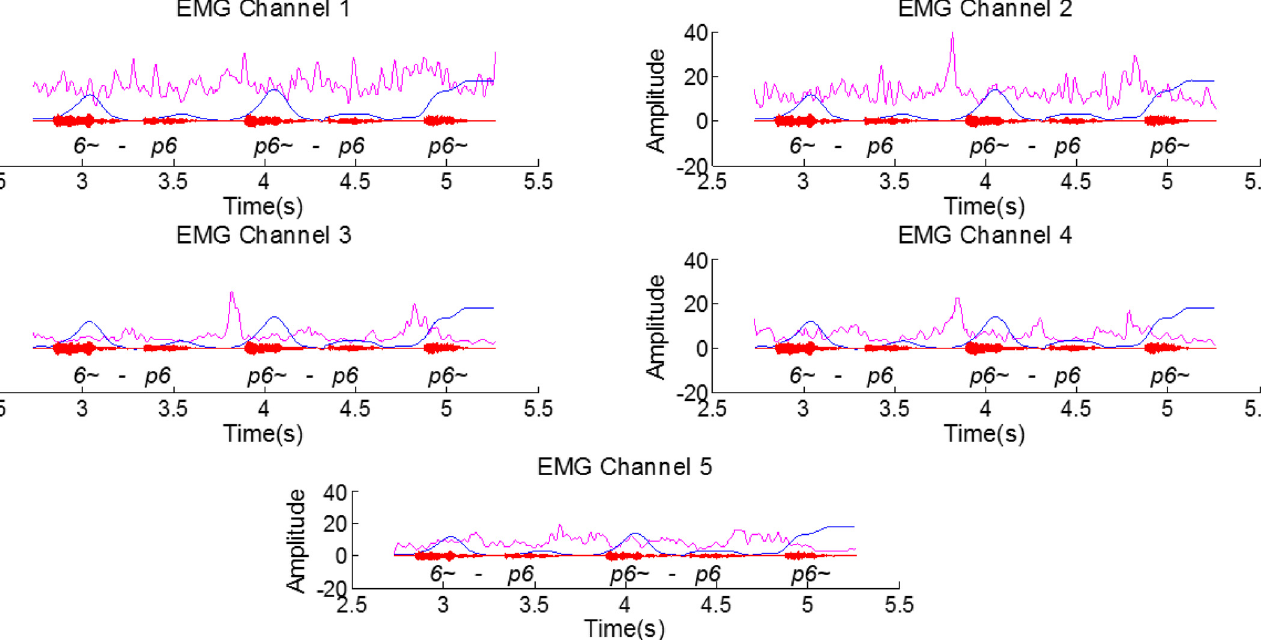
Fig 8. Filtered EMG signal (12-point moving average filter) for the several channels (pink), the aligned RT-MRI information (blue) and the respective audio signal for the sentence [6~p6, p6~p6, p6~] from speaker 1. An amplitude gain was applied to the RT-MRI information and to the EMG for better visualization of the superimposed